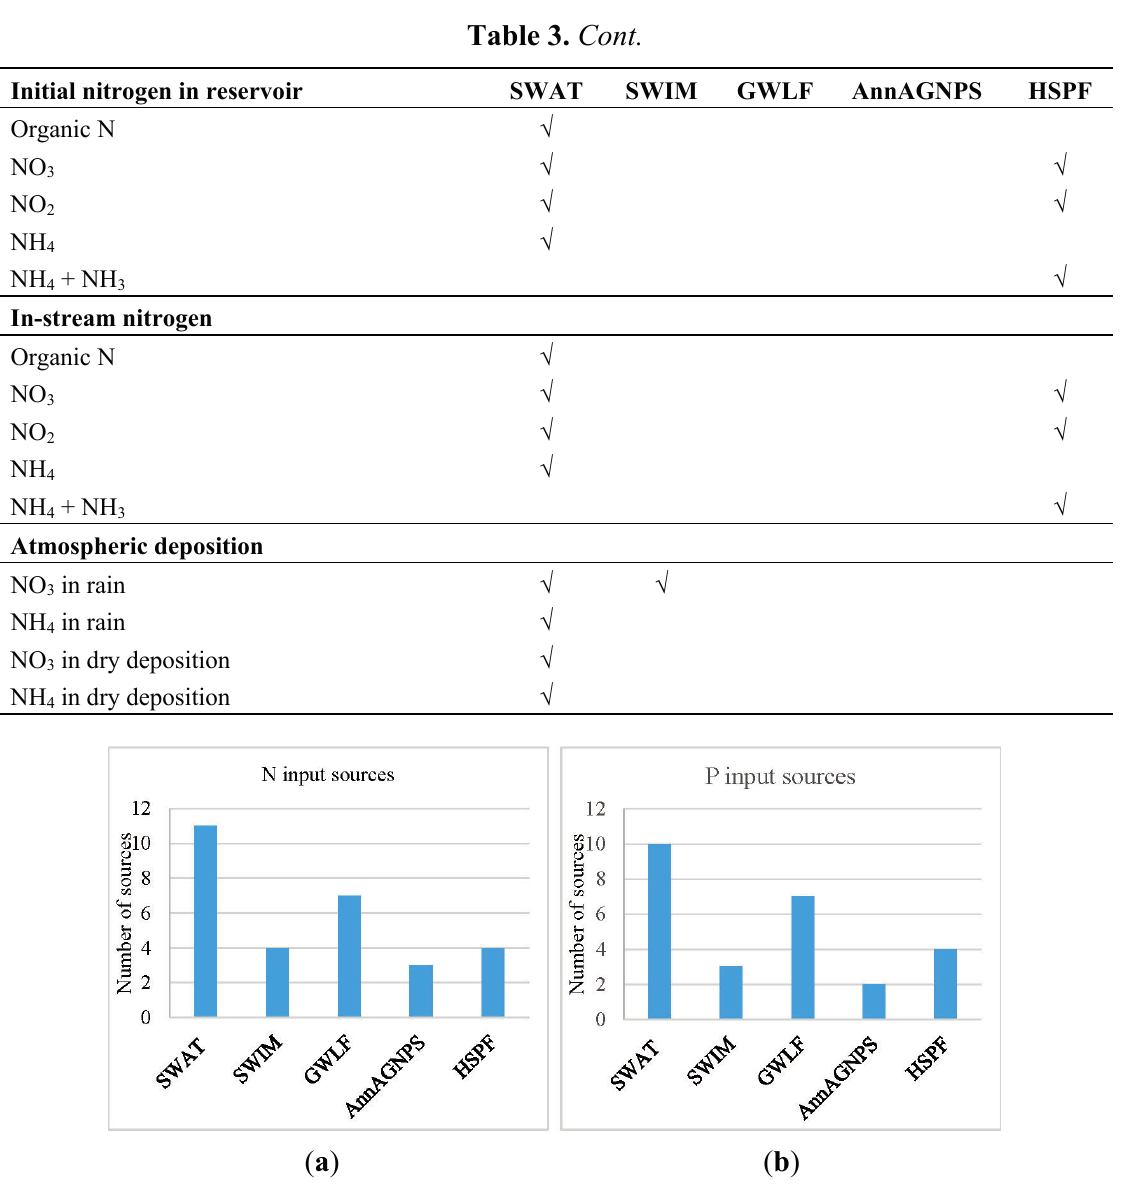
Figure 3. Numbers of nutrient inputs sources of the models: ( a ) N input sources; ( b ) P input